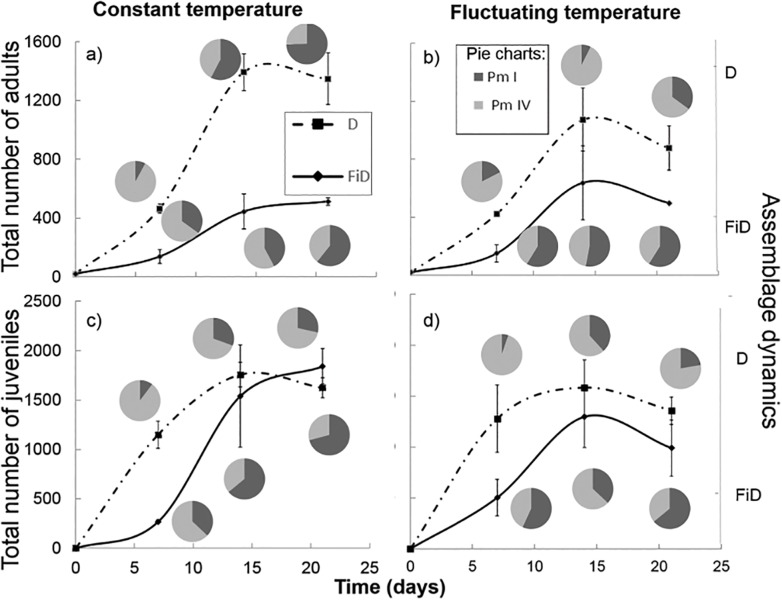
Total number of nematodes (adults: a + b, juveniles: c + d) over time in the different temperature treatments (constant temperature: a + c, fluctuating temperature: b + d) with assemblage dynamics at the different sampling times (three pie charts correspond with following time moments: 7, 14 and 21 days): upper pie charts for the D treatment (Pm I and Pm IV with interspecific interactions), lower pie charts are the dynamics in the FiD treatment (Pm I and Pm IV without interspecific interactions).